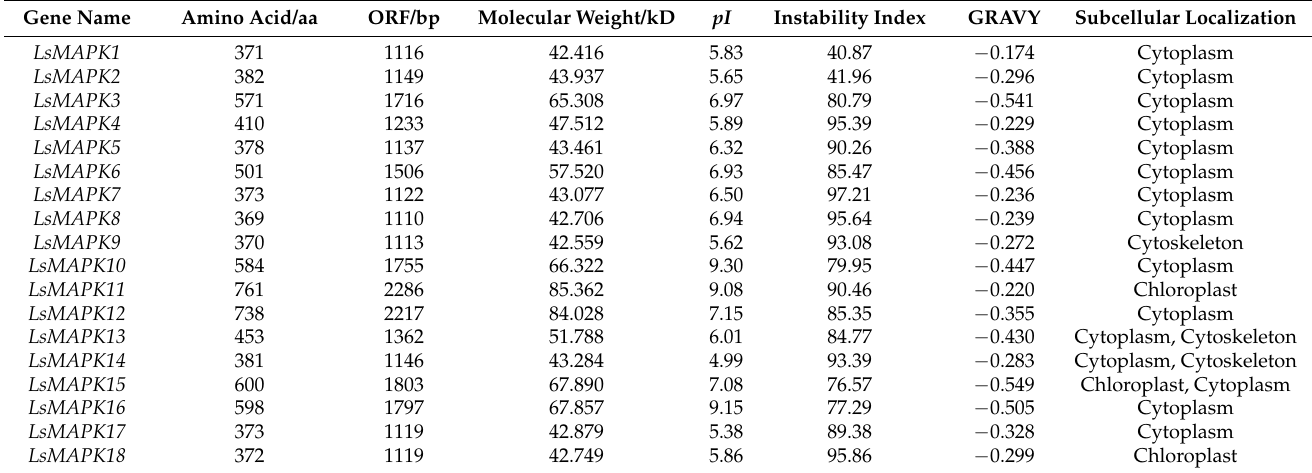
Table 1. The characteristic of LsMAPK